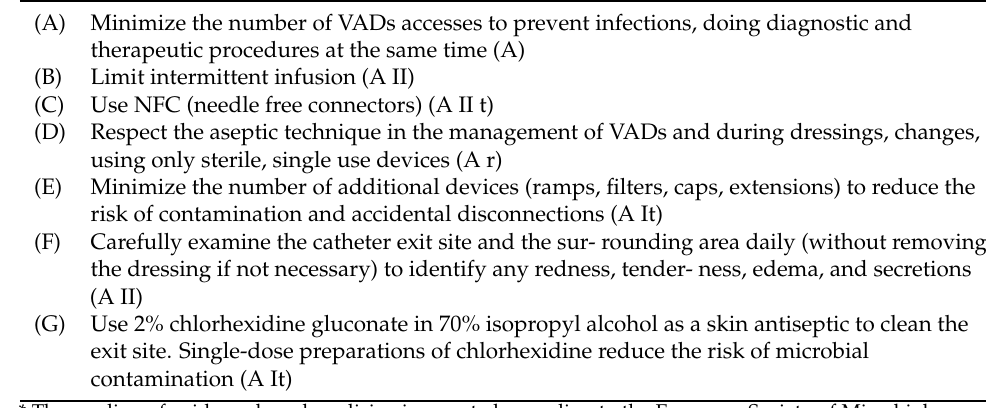
Table 2. AIEOP Recommendations for VADs Management